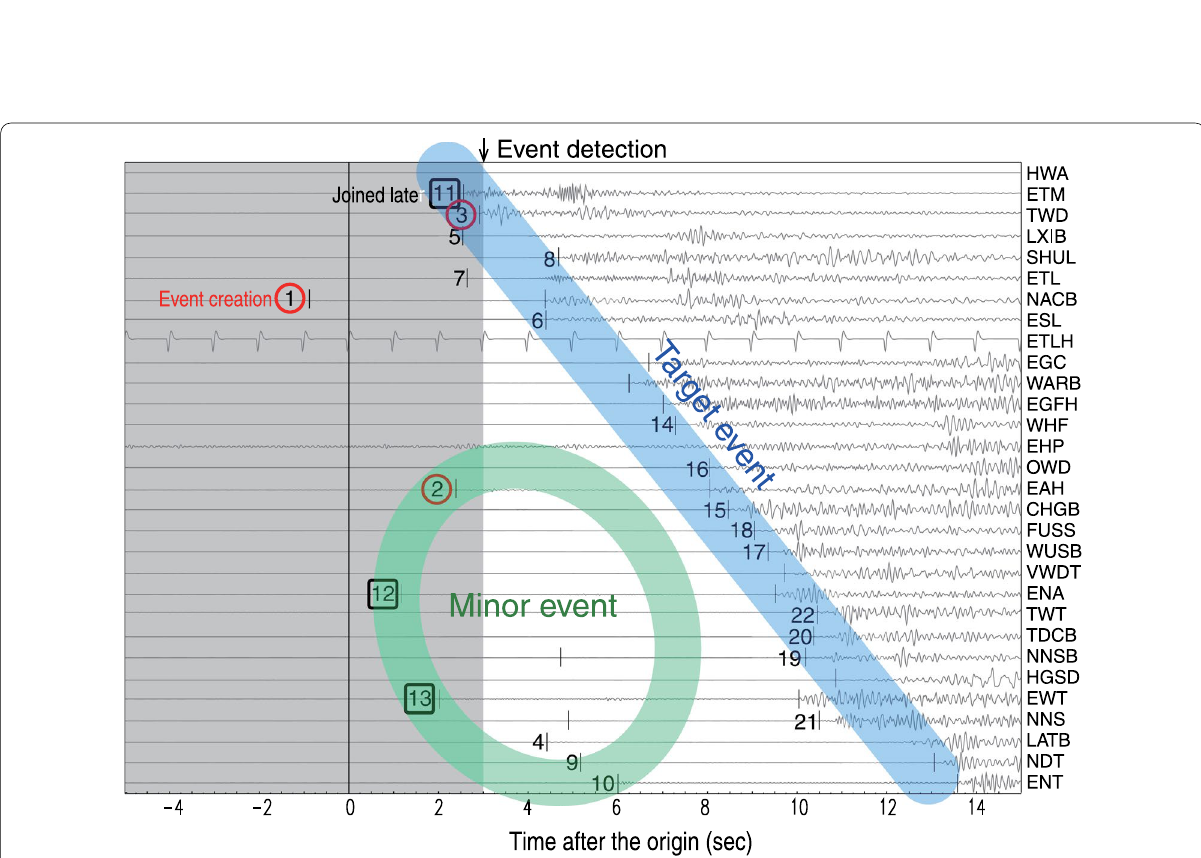
Fig. 6 Waveforms of the M 4.3 aftershock on February 6, 2018, in the order of the epicenter distance. The triggers are shown by the vertical lines. The number at the trigger line indicates the order in which the triggers contributed to the source estimation. Triggers Nos. 1, 2, and 3 were used for the event detection. The IPFx method scans triggers not used for the event detection for 3 s before the event detection, so Triggers Nos. 11, 12, and 13 were joined later. Triggers Nos. 5 and 7 were detected after the event detection and moved forward by trigger